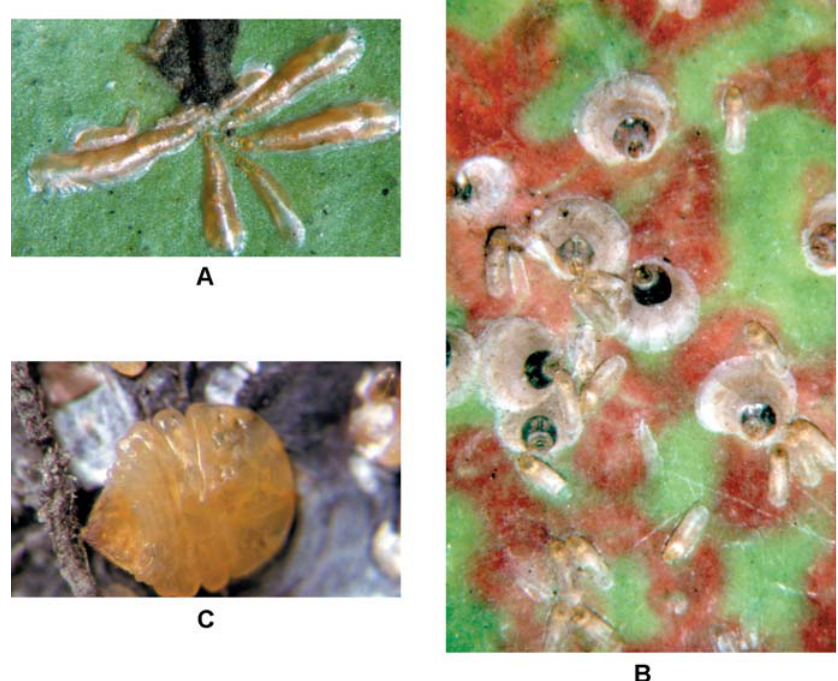
Figure 1. Armored Scale Insects (A) Lepidosaphes gloverii , adult females. (B) Parlatoria oleae , adult females (circular, with dark spot) and immatures (oblong). (C) Quadraspidiotus juglansregiae , adult female with waxy scale cover removed. (Photographs by Raymond J. Gill, © 2003 California Department of Food and Agriculture, published here under the terms of the Creative Commons Attribution